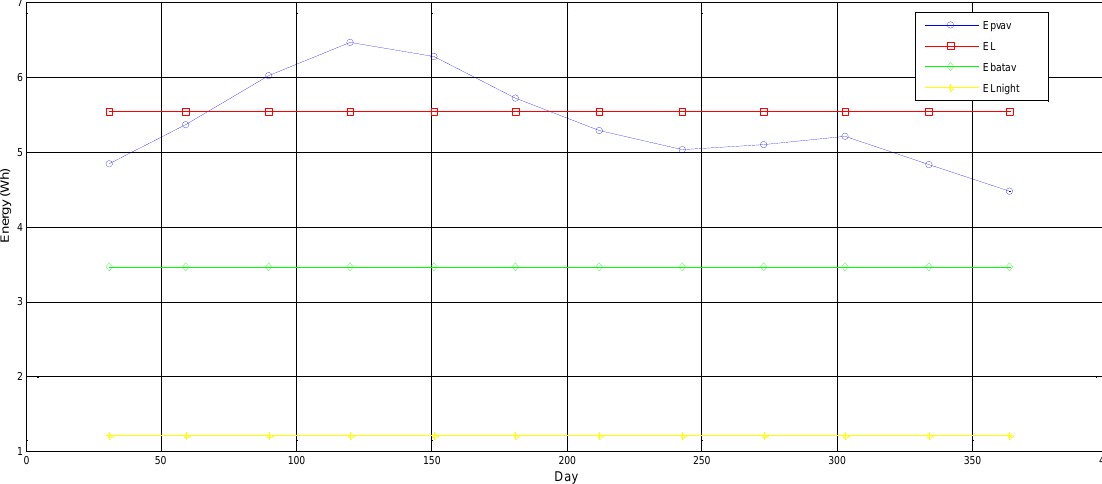
Figure 12 . Annual variation of PV average output (E PVav ), maximal load demand (E L ), average energy supplied by batteries (E batav ), and maximal load demand during night (E Lnight